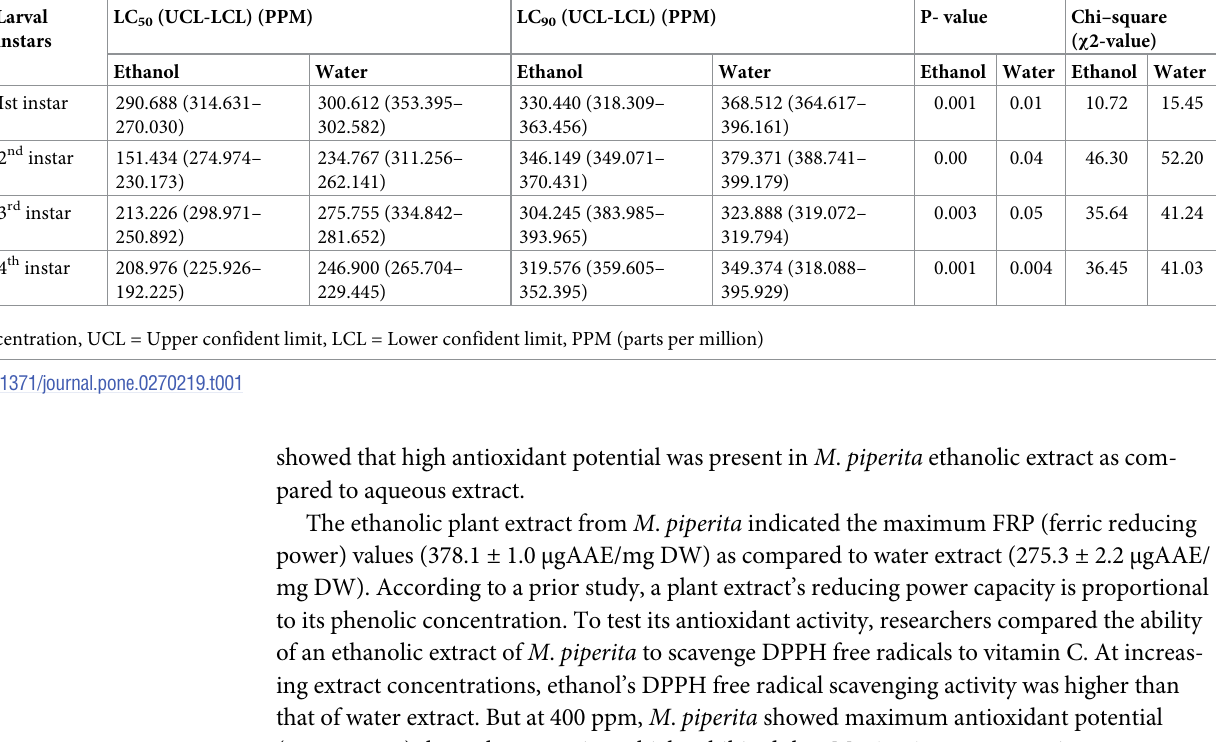
Table 1. Probit analysis (LC 50, LC 90 ), Chi- square and P-value of experimented plant. Plants Name Larval instars